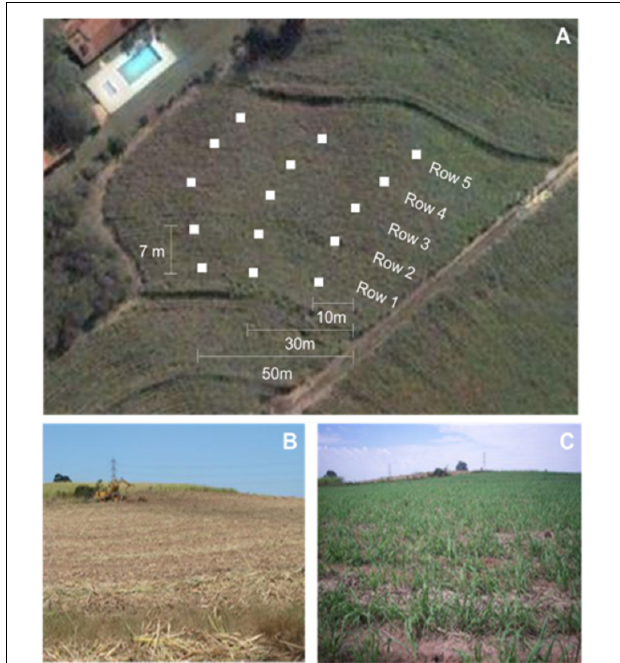
FIGURE 1 | Representation of the sugarcane field studied in Piracicaba, São Paulo, Brazil (S 22 ◦ 43 (cid:48) 07.9 (cid:48)(cid:48) , W 47 ◦ C 41 (cid:48) 91.7 (cid:48)(cid:48) ). (A) Experiment site area from a satellite view (Google maps). The field plot is shown in the center and the white squares represent the harvesting sites distribution. (B) Field of sugarcane cultivation after the harvest. (C) Field after 3 months with the new sugarcane plants